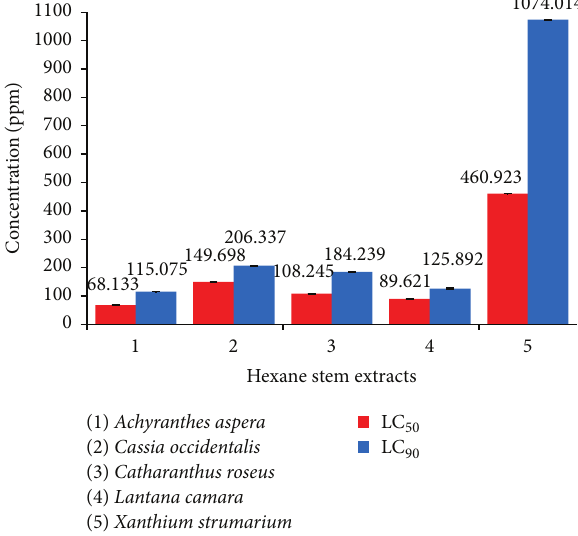
Figure 2: Percent mortality of hexane leaf extracts of different selected plants at different concentrations against early IV instars of Ae. aegypti .